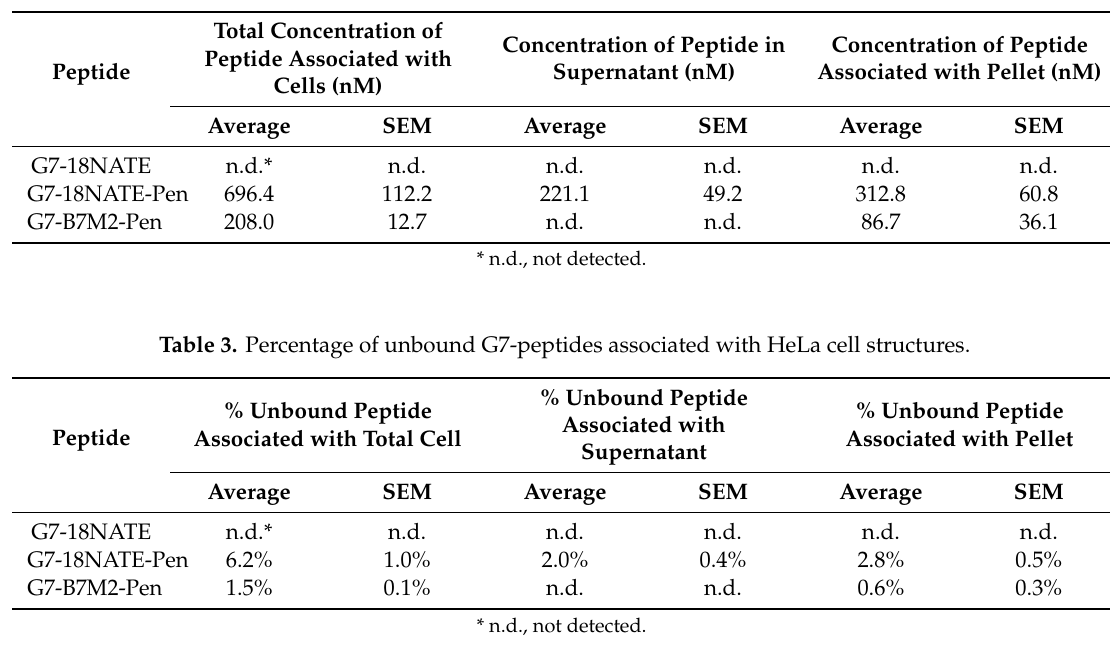
Table 2. Internalization and association of G7-peptides with HeLa cells. Total Concentration of Peptide